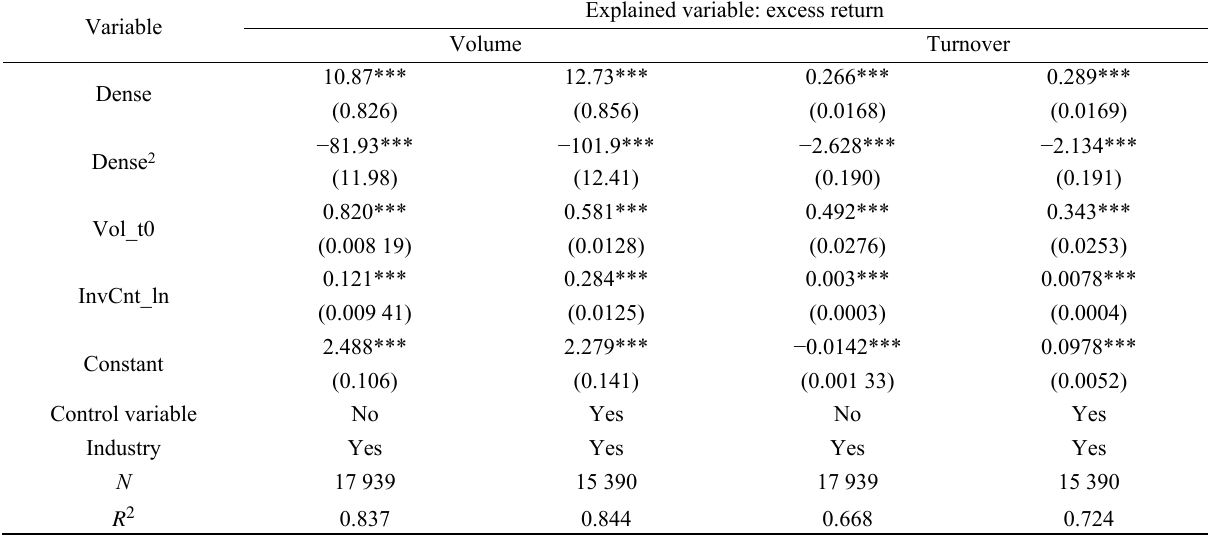
Table 15 Information diffusion speed and individual stock